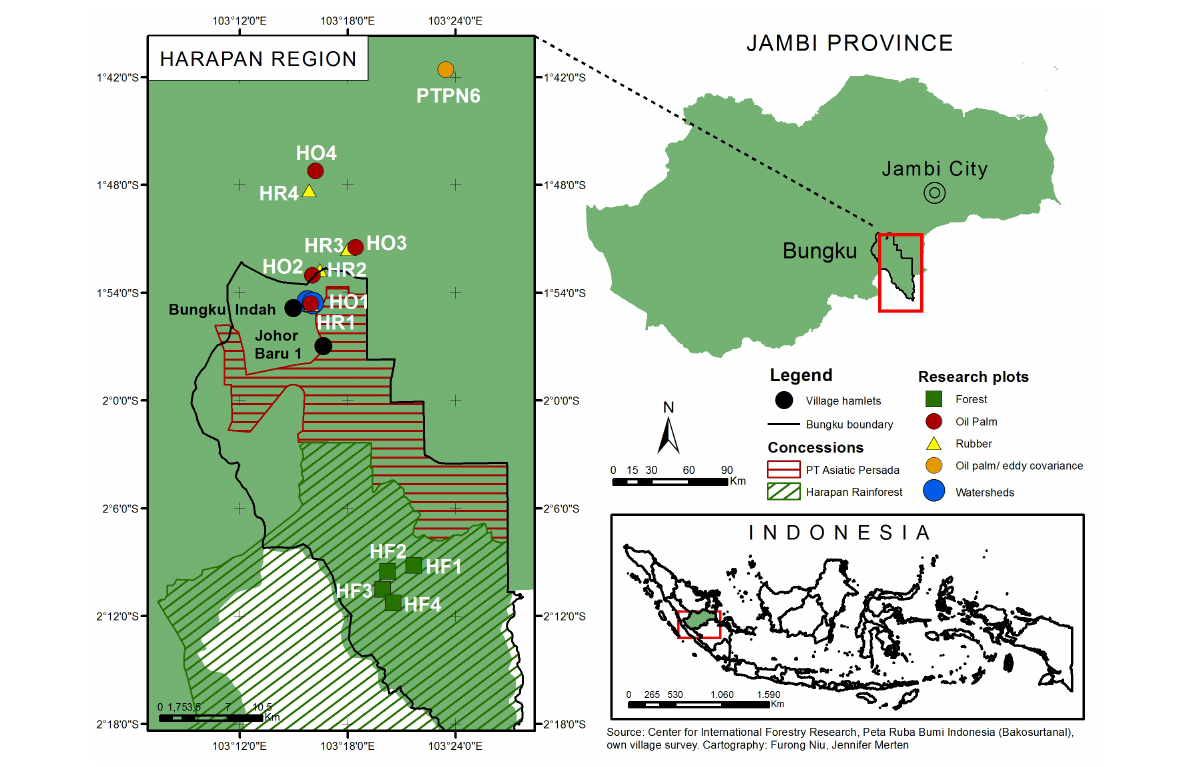
Fig. 1 . Location of the study sites in Jambi province, Sumatra,